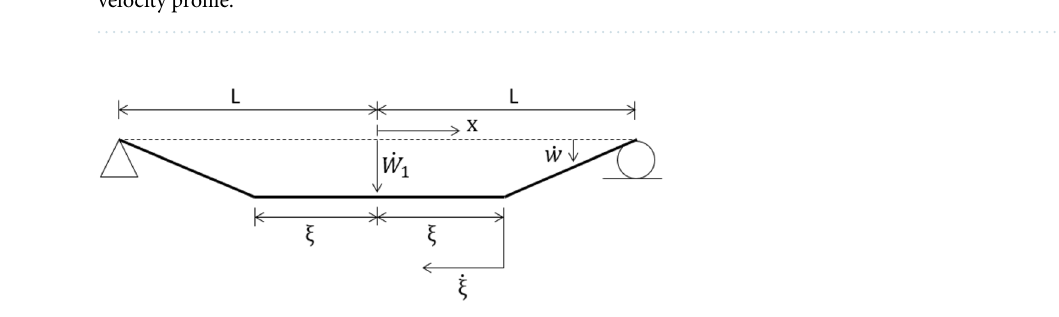
Figure 5. Illustration of impulsively loaded simply supported beam having a rectangular transverse initial velocity profile.